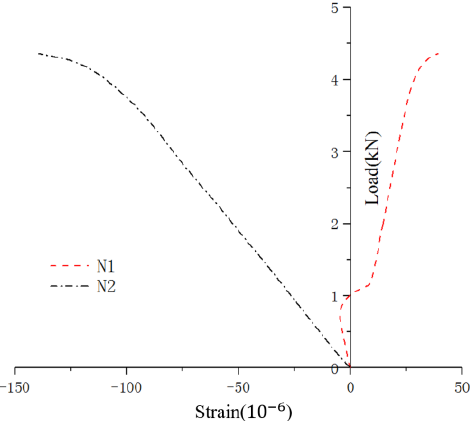
Figure 9. Load-strain relationship of the new composite thin-shell in the Position N.